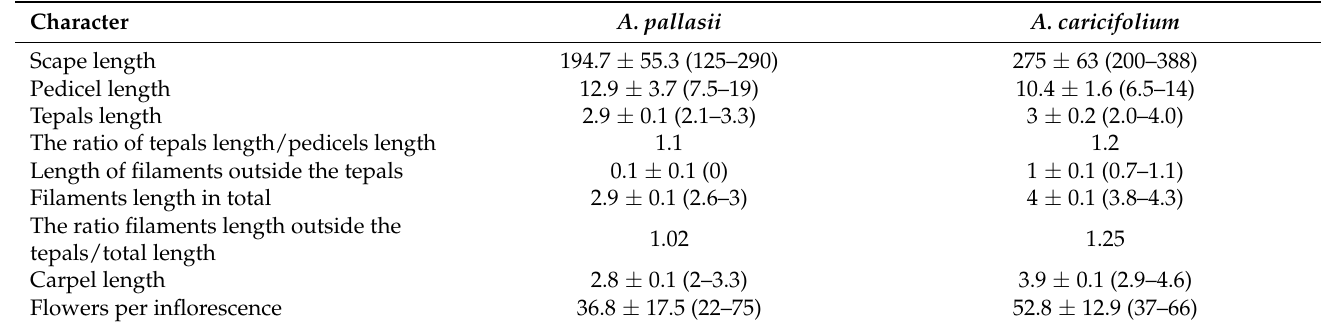
Table 1. Comparison of morphological characters of A. pallasii (20 individuals) and A. caricifolium (22 individuals). Quantitative characters are expressed in mm and presented as mean ± standard deviation (extreme values in